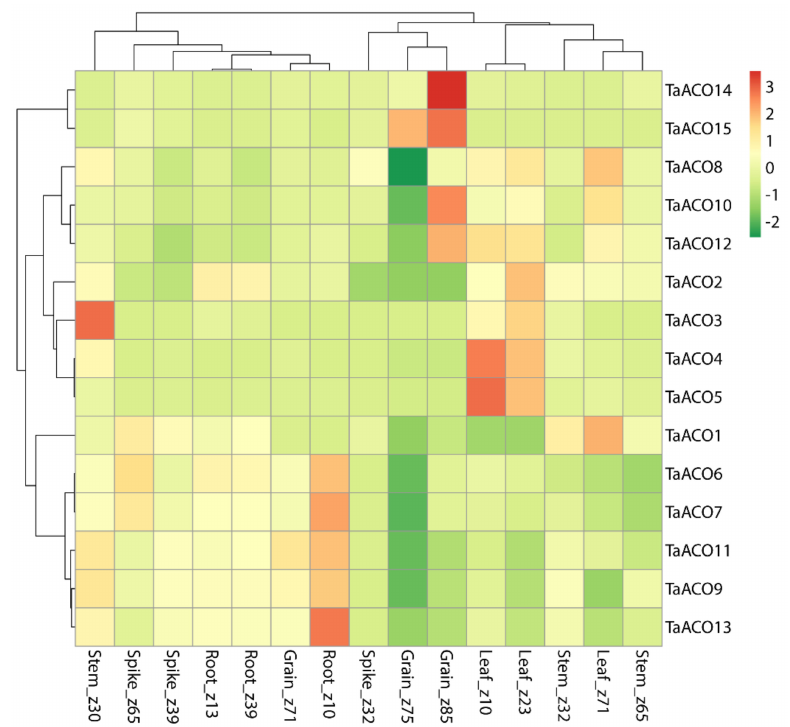
Figure 8. Heatmap demonstrating expression pattern of the TaACO s in different tissues and develop- mental stages. Columns indicate genes and rows denote different tissues and developmental stages. TPM numbers were directly used to produce the